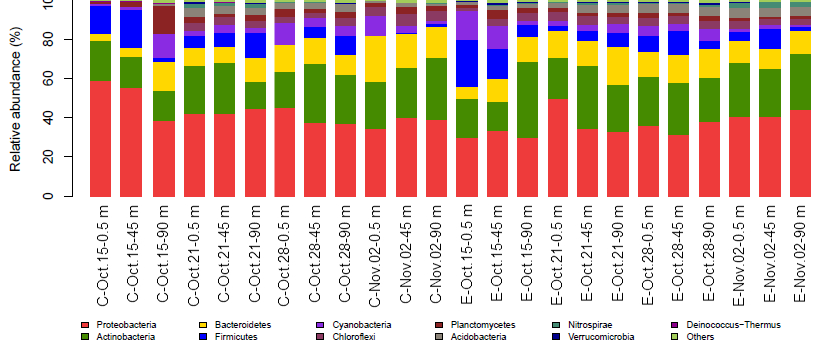
Figure 5. Variation of microbial phyla in the enhanced and control areas (E—indicates “enhanced area”; C—indicates “control area”).